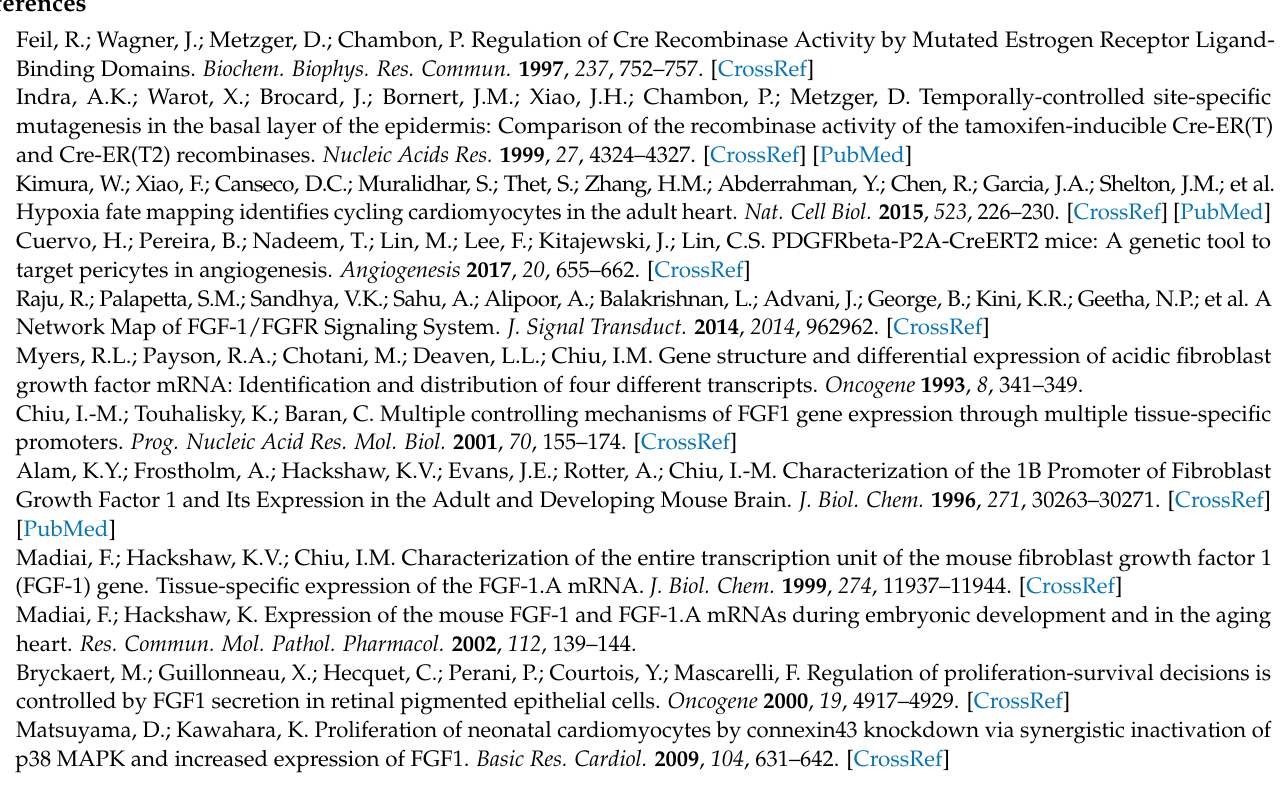
Figure S2: PCR results of R26F2/LacZR, R26F2/R1295, R26F2/LacZR, R26F2/R1295, R26F2/LacZR and R26F2/R1295 (internal control). Figure S3: LacZ stainging in the heart of E18 embryo. Supple- mentary Table S1: Primers for PCR, Supplementary Table S2: Primer for